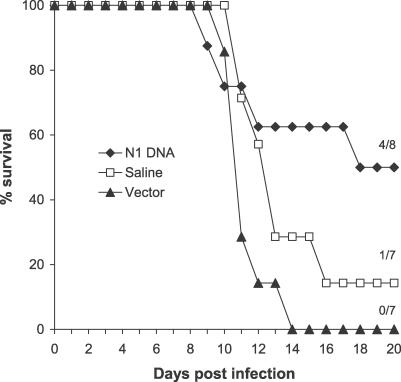
Sequence Dependence of huN1 DNA Vaccine Induced Protection against Lethal H5N1 InfectionMice vaccinated at week 0 and week 3 with huN1 DNA (n = 8), saline (n = 7), or empty plasmid vector (n = 7) were challenged with 10 MLD50 of A/Vietnam/1203/04 (H5N1) at week 6. Survival was monitored daily. Although the difference in mortality between saline-injected and huN1 DNA–vaccinated groups did not reach statistical significance (p = 0.18), the difference in mortality between huN1 DNA vaccinated mice and those given empty vector DNA approached significance (p = 0.051). Statistical comparison is by Fisher's exact test.